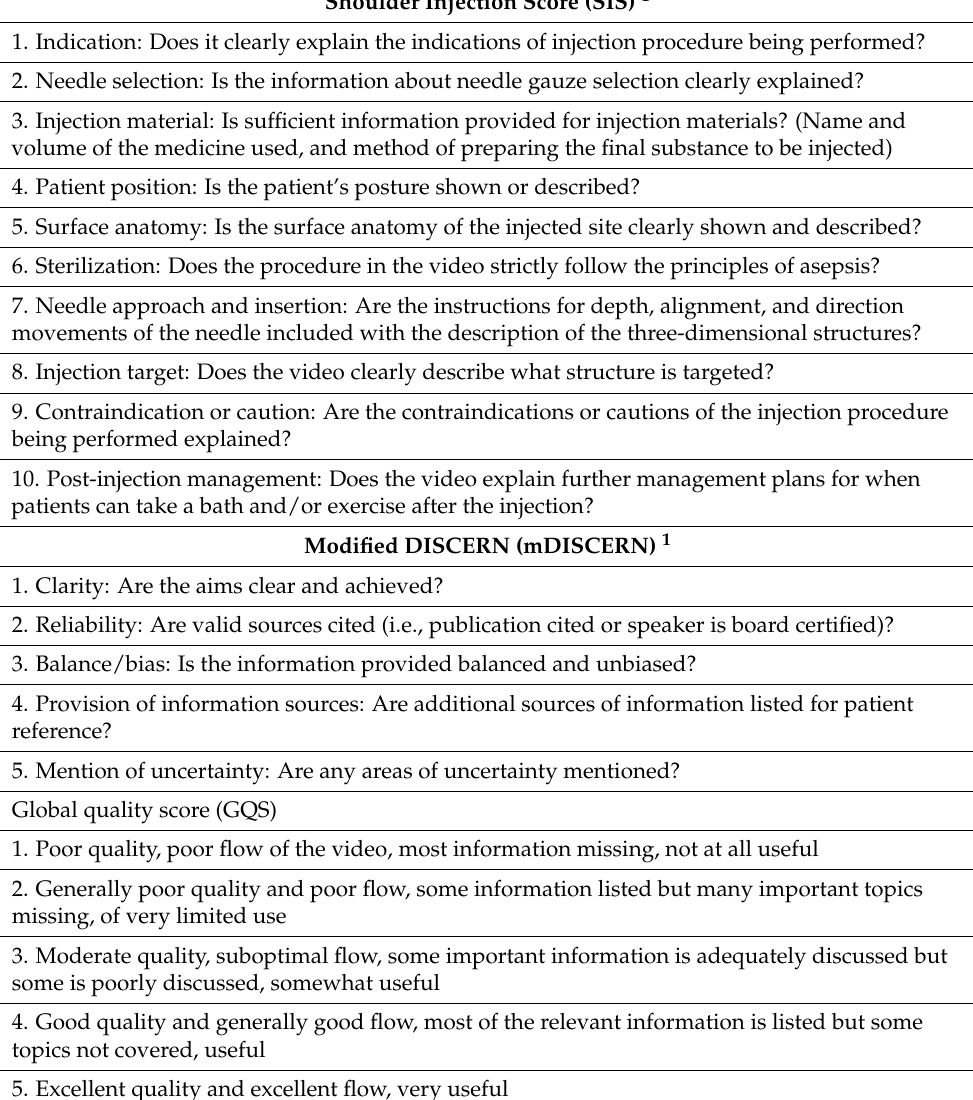
Table 1. Description of the components of the tools to evaluate videos with information on shoulder injection